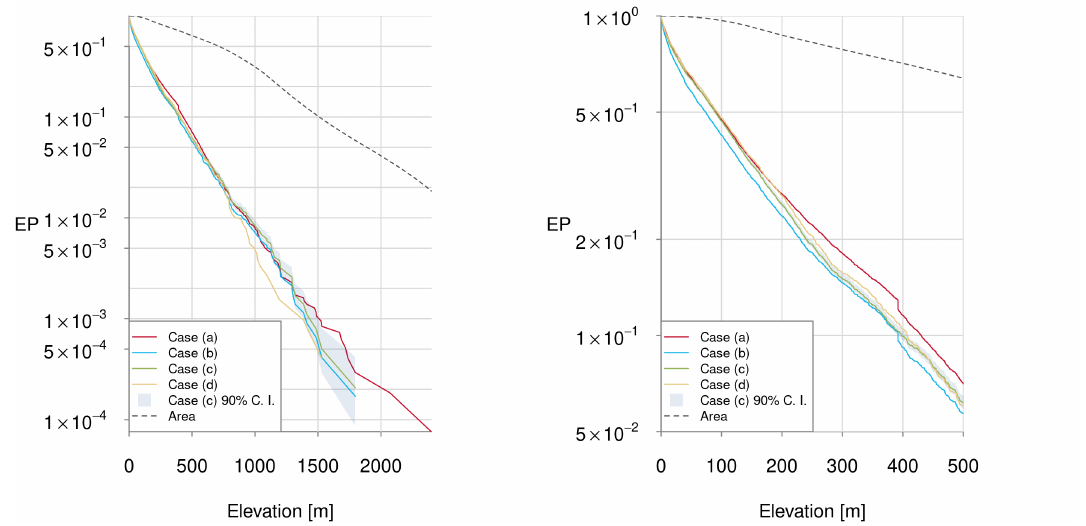
Figure 6. Exceedance probability curves of tornado observations for 4 cases: (a) all recorded tornadoes (red line), (b) tornadoes recorded in the period 2005–2019 (blue line), (c) tornadoes recorded in the period 2005–2019 that touched land (green line) and (d) tornadoes recorded in the period 2005–2019 that touched land and have an intensity rating (yellow line). Right graph is restricted to elevations below 500 m for better visibility. The 90% confidence interval is drawn for case (c) as shaded region, tornadoes that hit land in the period 2005–2019. The exceedance probability (EP) curve for the distribution of area over elevation is also shown by a dashed